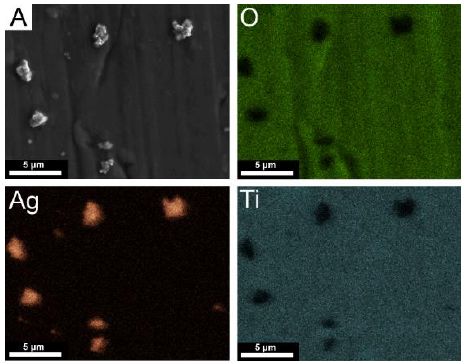
Figure 5. Elemental distribution map and chemical composition from a selected area, Specimen A.